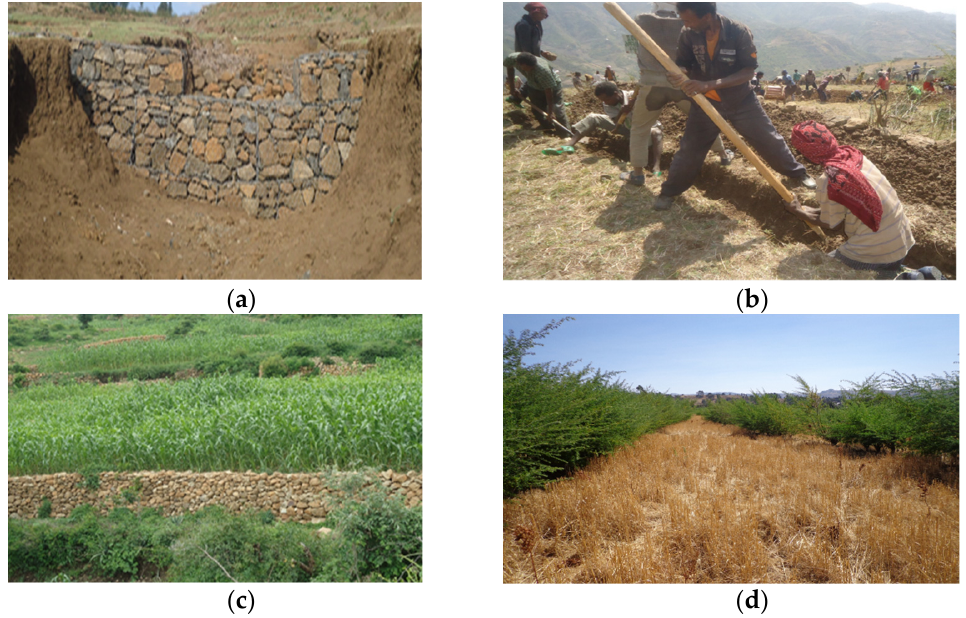
Figure 9. Some of the SWCPs practiced in the area: ( a ) check dam with gabion; ( b ) soil bund; ( c ) stone bund; and ( d ) alley farming. Photo credit: South Wollo Agriculture and Natural Resource Management Office and the